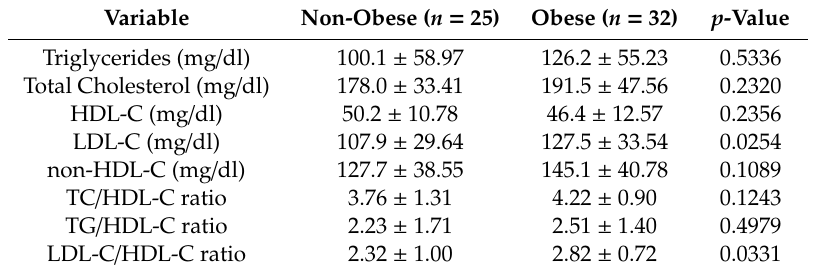
Table 5. Lipid profile based on the classification as obese or not according to body fat